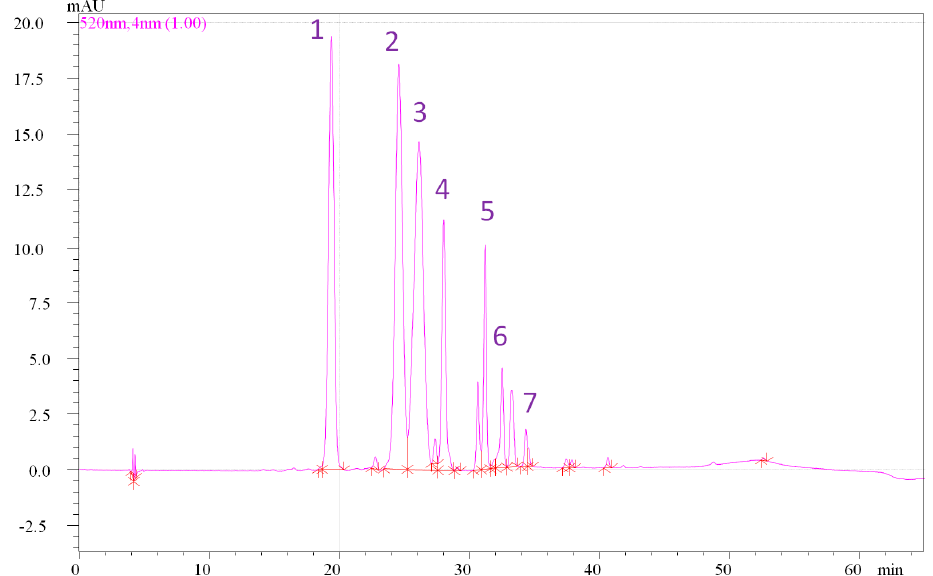
Figure 4. HPLC chromatogram of anthocyanins identified from C. mirabile flowers (FC6). Peak no. 1, Cyanidin 3,5-di- O -glucoside; 2, Peonidin 3,5-di- O -glucoside; 3, Malvidin 3,5-di- O -glucoside; 4, Peonidin 3-rutinoside; 5, Peonidin 3- O -glucoside; 6, Malvidin 3- O -glucoside; 7, Malvidin 3-rutinoside. Conversely, in Slovenian C. purpurascens flowers, high amounts of malvidin 3,5- diglucoside and delphinidin-3-glucoside were detected [34]. These results are in accordance with Boase et al. (2010) which isolated the anthocyanins from the flowers of transgenic C. persicum through flavonoid 3 (cid:48) ,5 (cid:48) -hydroxylase suppression [89]. Thus, in purple